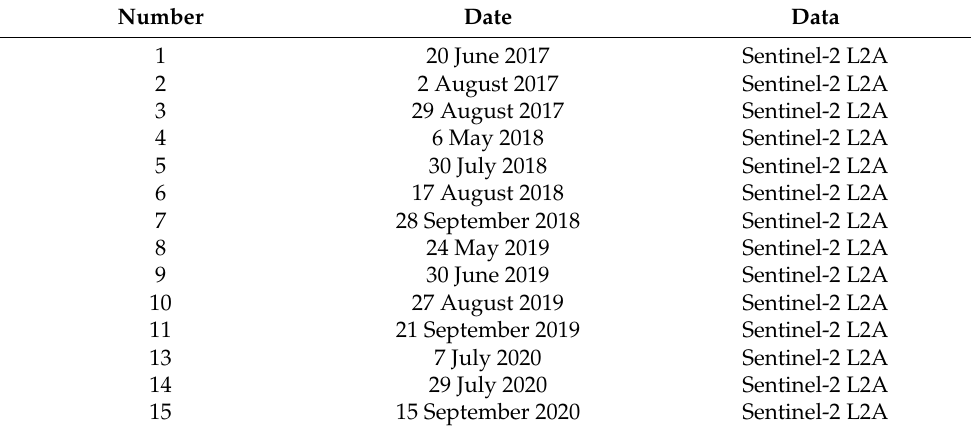
Table 1. Sentinel-2